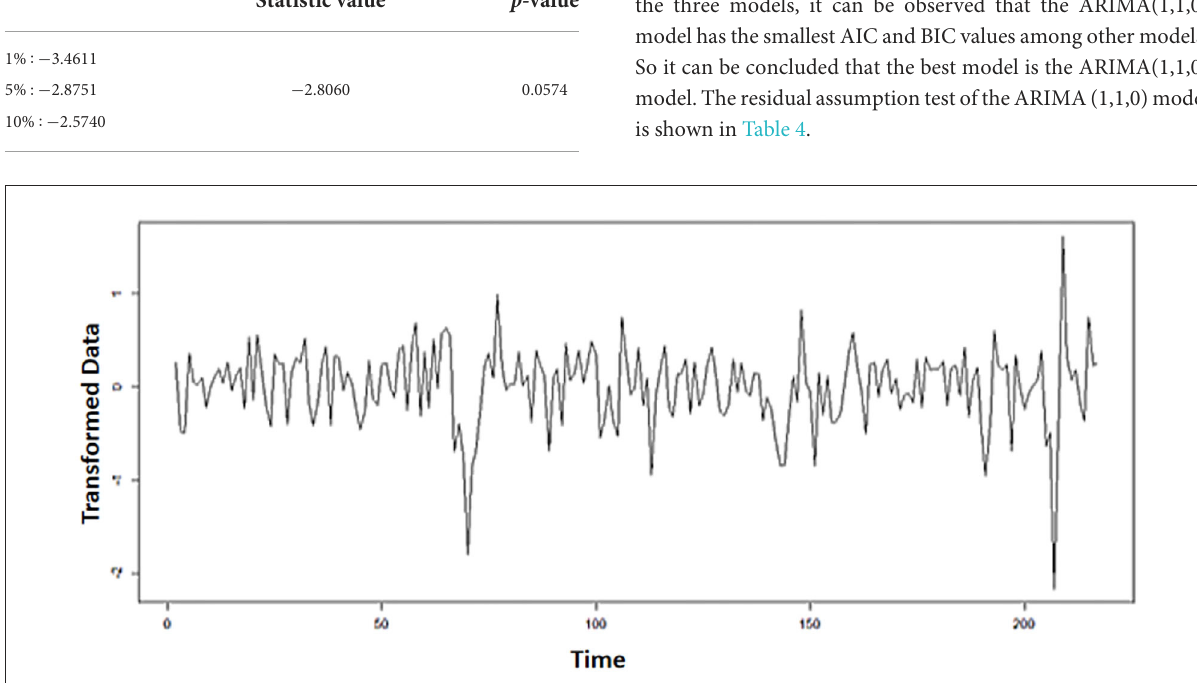
FIGURE2 WTI oil data plot after transformation and